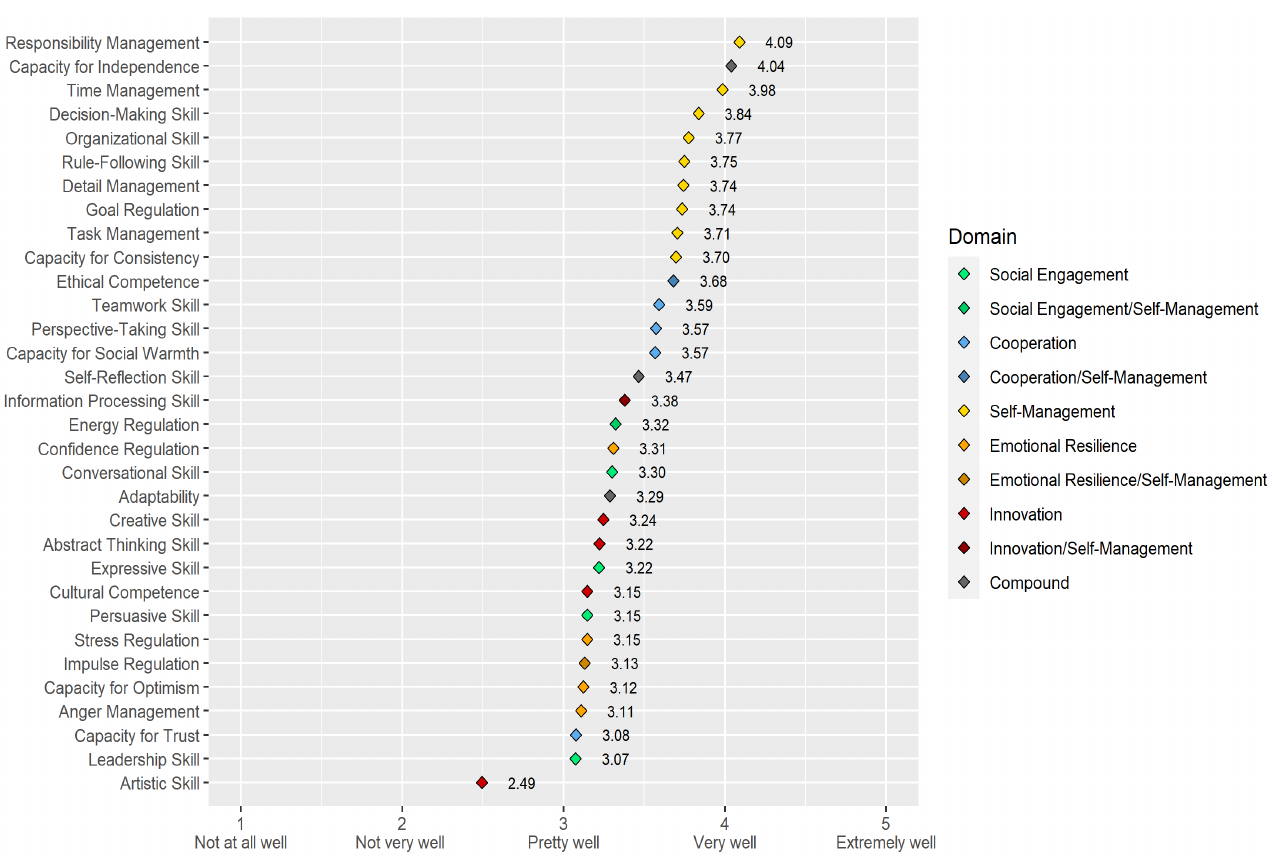
Figure 4. Sample means of the SEB facet scores.